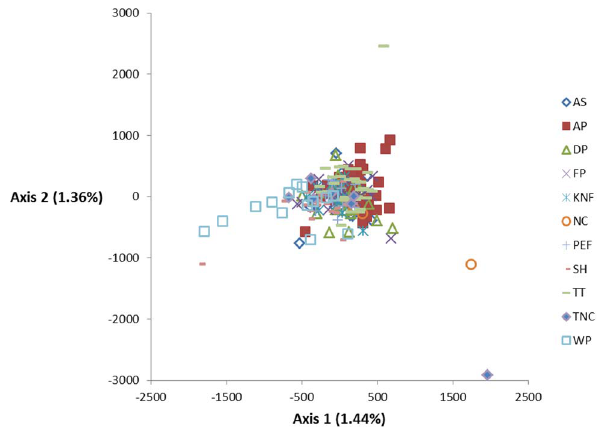
Figure 6. Factorial correspondence analysis of 226 Bachman’s Sparrow individuals from eleven study populations. Population abbreviations are as follows: Abita Springs (AS), Avon Park (AP), Dry Prong (DP), Fort Polk WMA (FP), Kisatchie National Forest (KNF), North Carolina (NC), Palustris Experimental Forest (PEF), Sandy Hollow WMA (SH), Tall Timbers Research Station (TTRS), Talisheek Pine Wetlands Preserve (TNC), Camp Whispering Pines (WP).